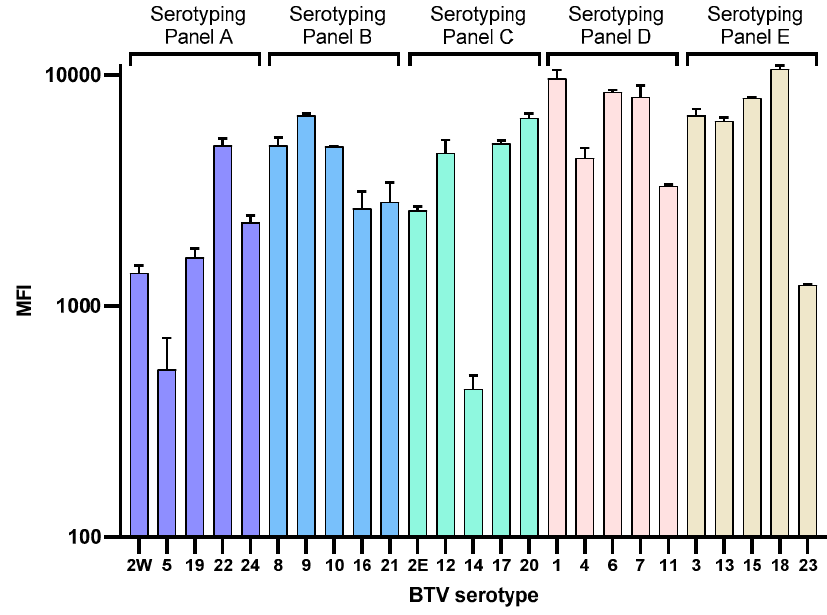
Figure 2. Performance of the BTV xMAP assay to detect BTV reference strains (1–24). For each of the serotyping panels (A–E), the median fluorescent intensity (MFI) is shown on the y axis while the x-axis represents the serotype detected. Samples tested in duplicate; error bars represent standard deviation.